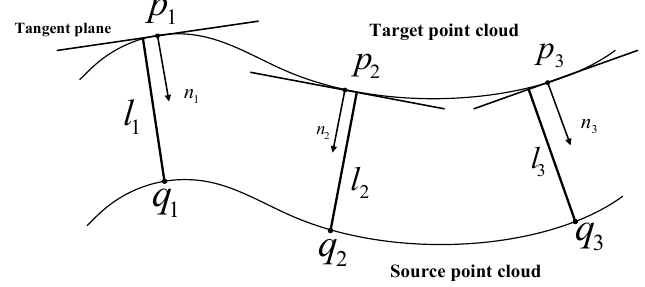
Figure 5. Diagram of the point-to-plane ICP algorithm.